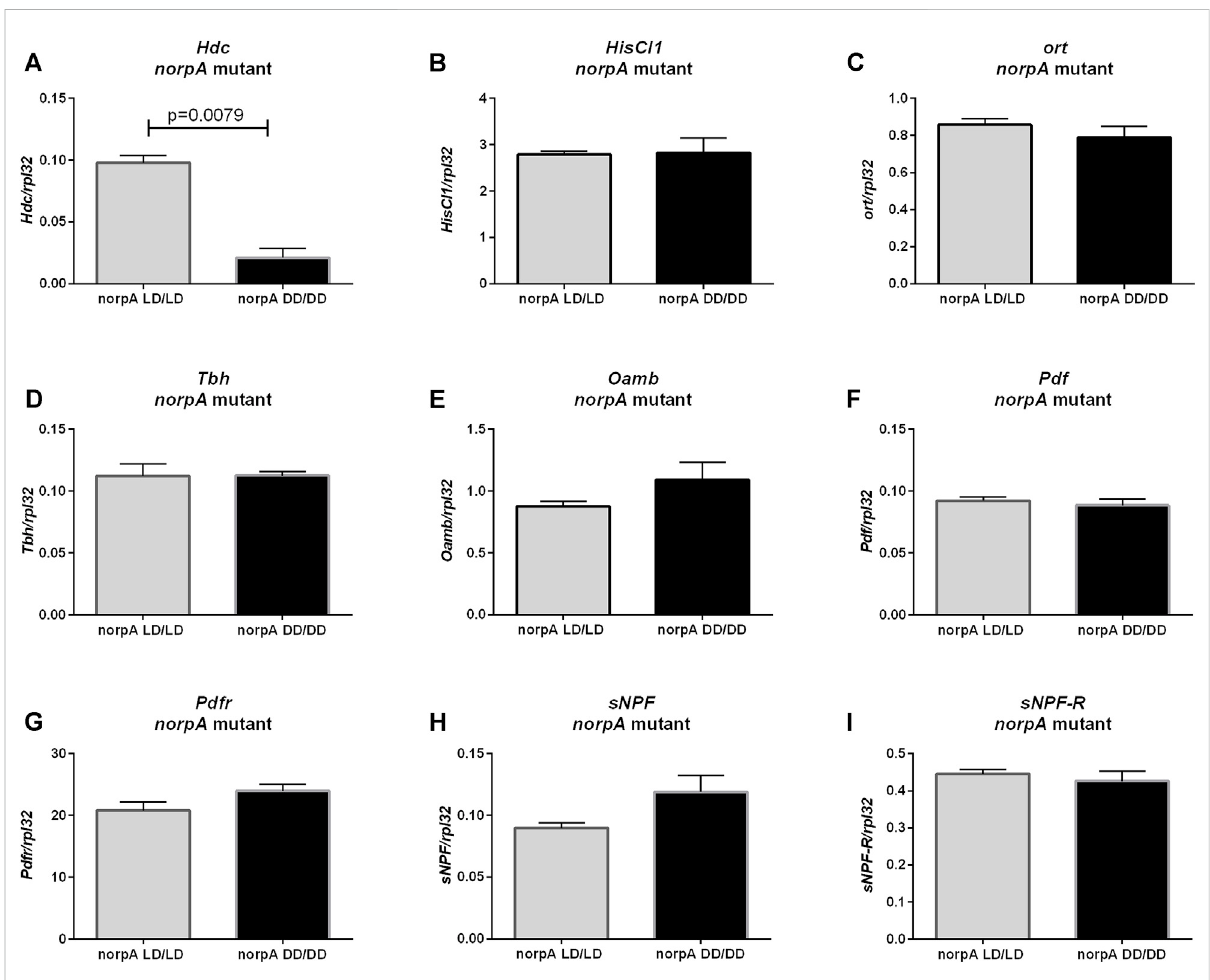
Effect of light on neurotransmitters pathway in norpA mutants. mRNA level was changed only for (A) Hdc gene. Histamine receptors: (B) HisCl1 and (C) ort were expressed on the same level. Octopamine signaling seems to be not affected: (D) Tbh , (E) Oamb . Clock signaling was not changed: (F) Pdf , (G) Pdfr , (H) sNPF , (I) sNPF-R . N = 5. Mean ± SEM.